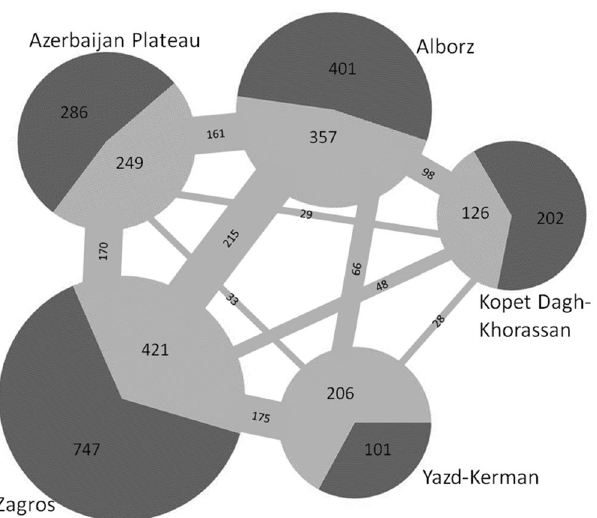
Figure 6. Endemic vascular plant species of Iran in areas of endemism. Endemic vascular plant species restricted to an area of endemism are indicated in dark grey, whereas those shared with other areas of endemism are indicated in light grey, their numbers being given in the bars connecting pie charts corresponding to areas of